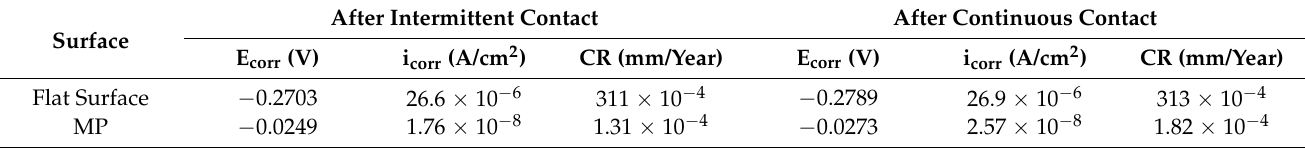
Table 3. Corrosion parameters (E corr , i corr , and corrosion rate, CR) of the flat surface and micropillar surface [1] (MP) after long-time contacts with NaCl